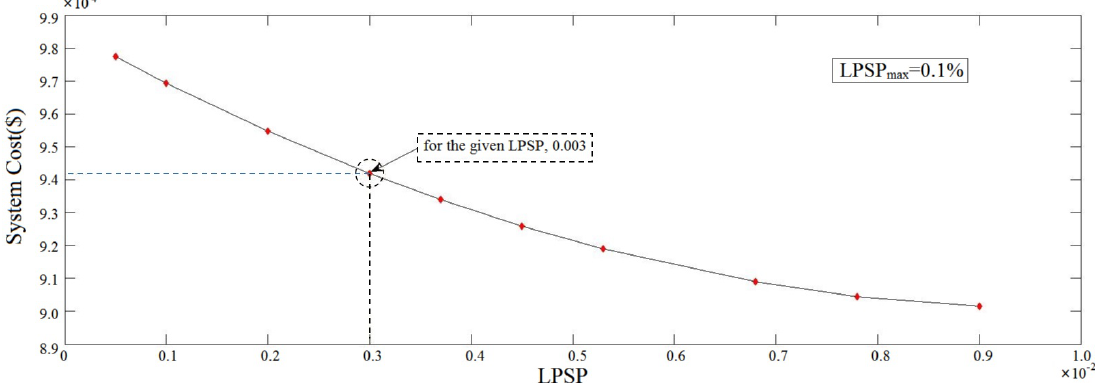
Figure 10. Simulation result for different LPSP.